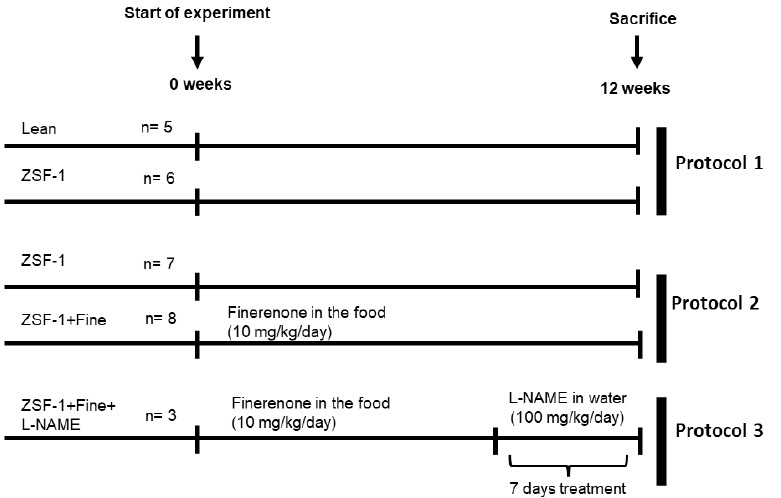
Figure 5. Scheme of the experimental protocol. Fine, finerenone; L -NAME, N ( ω )-nitro- L -arginine methyl ester.